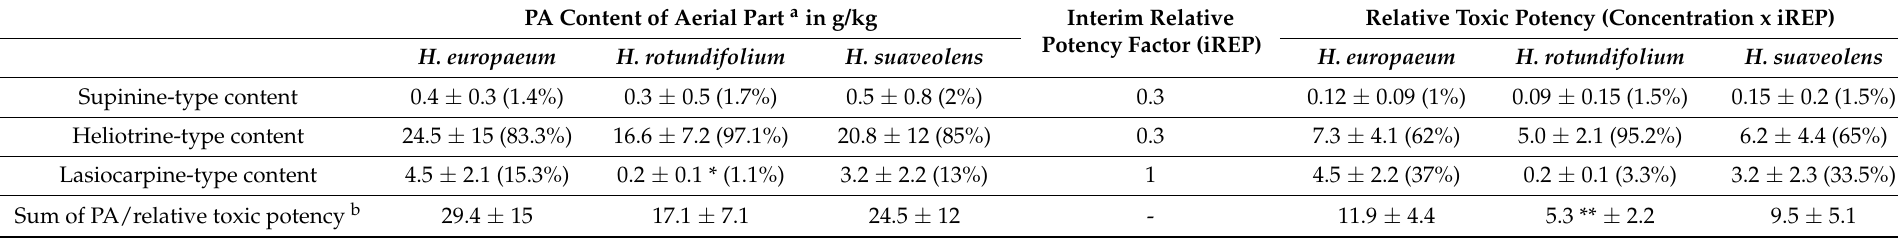
Table 2. Relative toxic potencies of H. europaeum, rotundifolium and suaveolens , based on their average PA content in the aerial part of the plant (leaves, stems and flowers) and the corresponding relative toxic equivalent of each PA